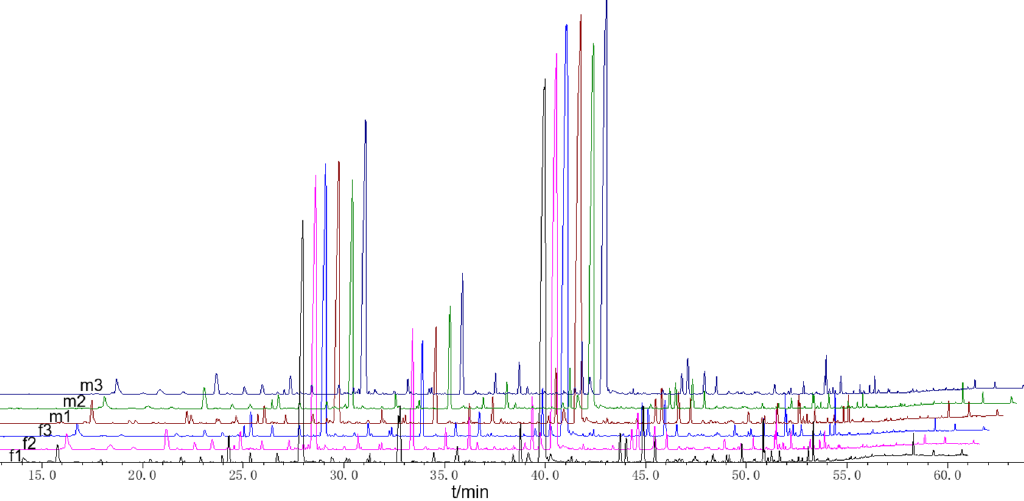
Figure 3. GC-MS total ion chromatograms of volatile compounds from female and male buds of T. anguina .